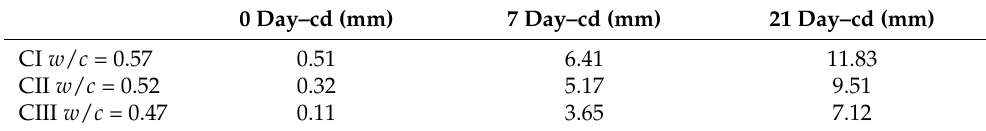
Table 3. The average carbonation depth.